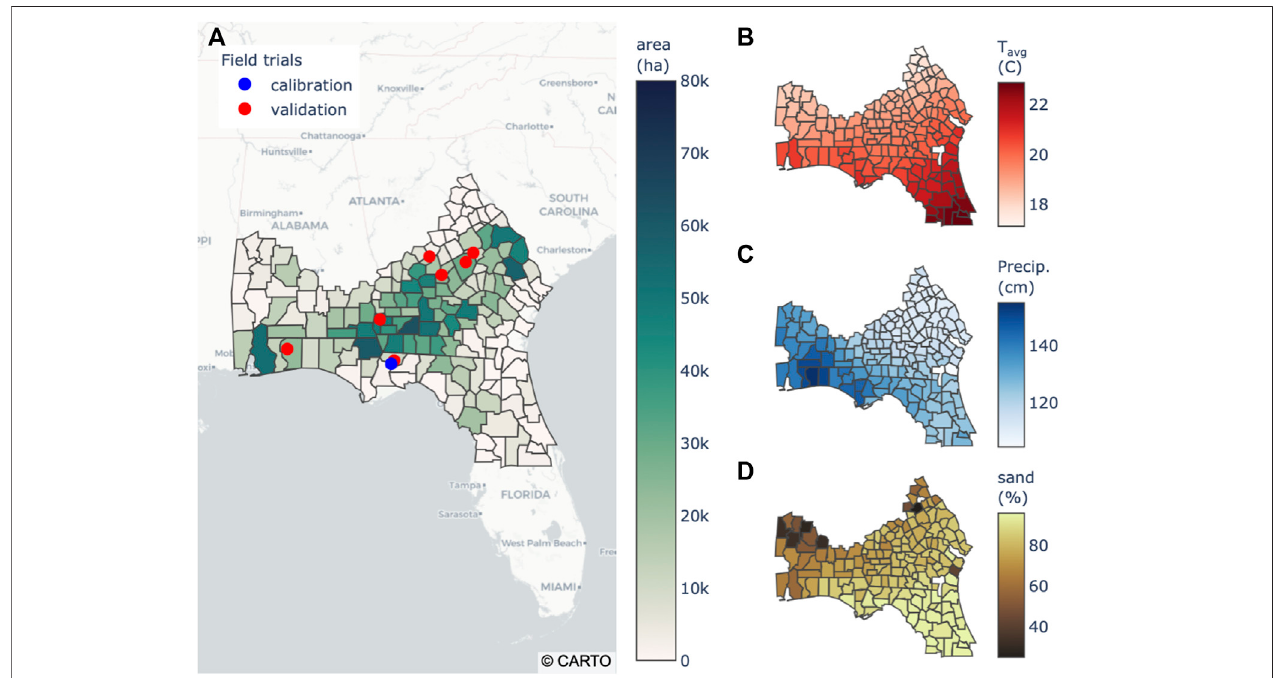
FIGURE 1 | Study area characteristics based on spatial data inputs used with the DayCent model. (A) Cultivated cropland area as per NLCD, with locations of carinata trials used for calibration (blue marker) and validation (red markers). (B) Average air temperature and (C) annual total precipitation as per NARR. (D) Average sand content of the surface soil layer as per SSURGO, considering cropland areas